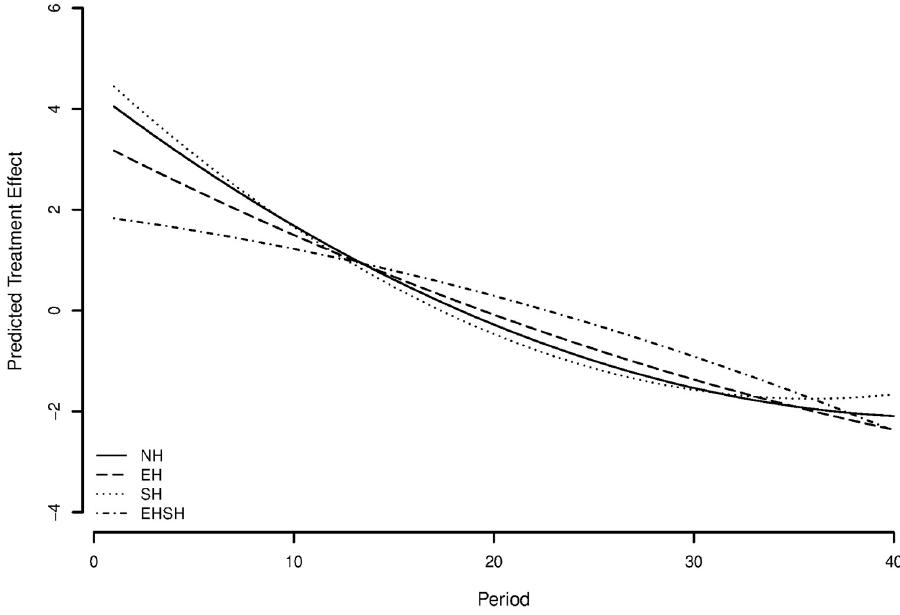
Fig 9. Predicted treatment effects on appropriation effort using multilevel regression